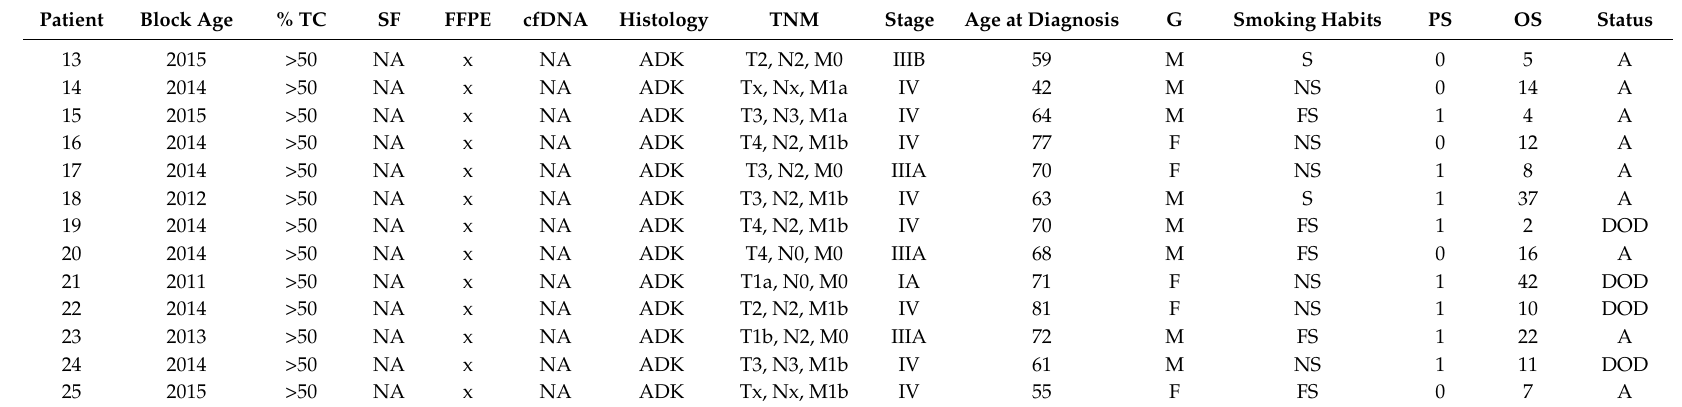
Table 3. Clinical characteristics of NSCLC patients in the “Validation